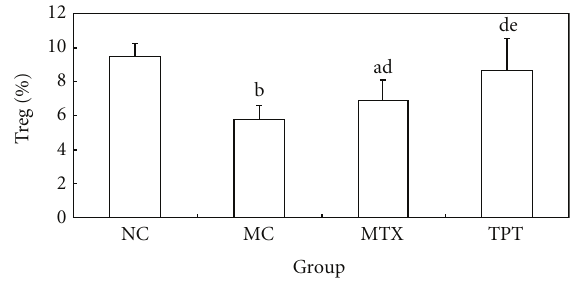
Figure 2: Comparisons of regulatory T cells in each group. Note: Compared with NC group, a P < 0 . 05, b P < 0 . 01; compared with MC group, c P < 0 . 05, d P < 0 . 01; compared with MTX group, e P < 0 . 05, f P < 0 .